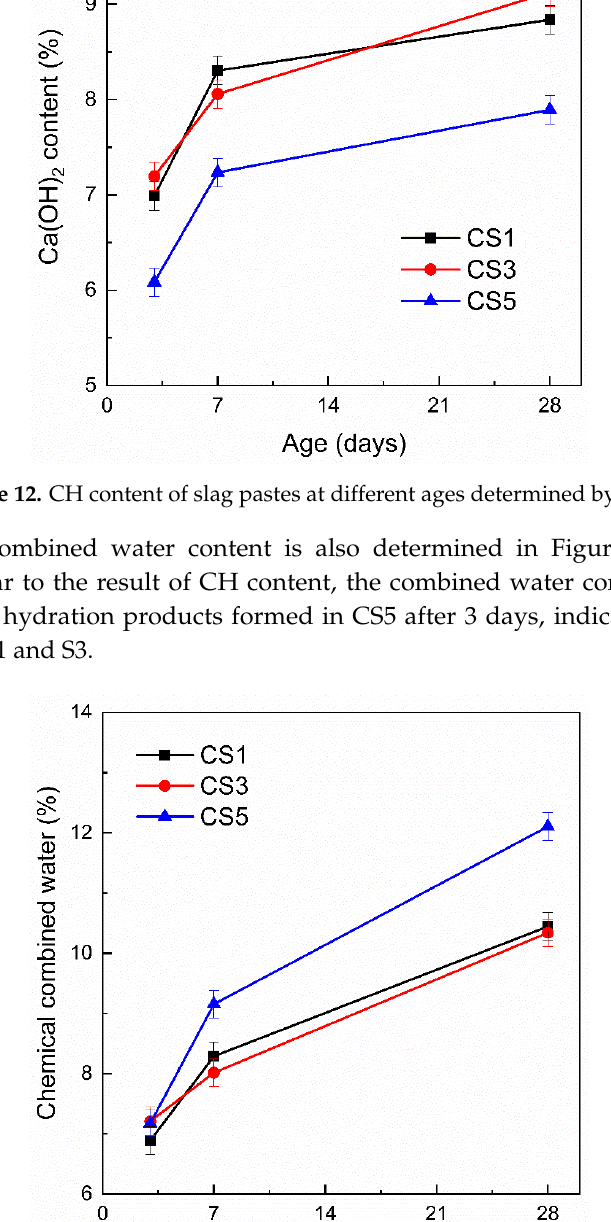
Figure 13. Chemical combined water of slag pastes at different ages determined by thermogravimetric analysis